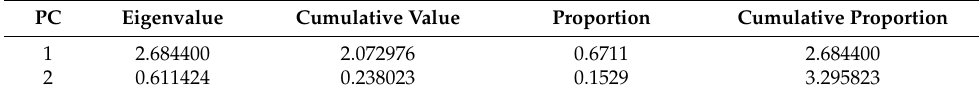
Table 3. PCA analysis of SOE stock returns in the banking sector.